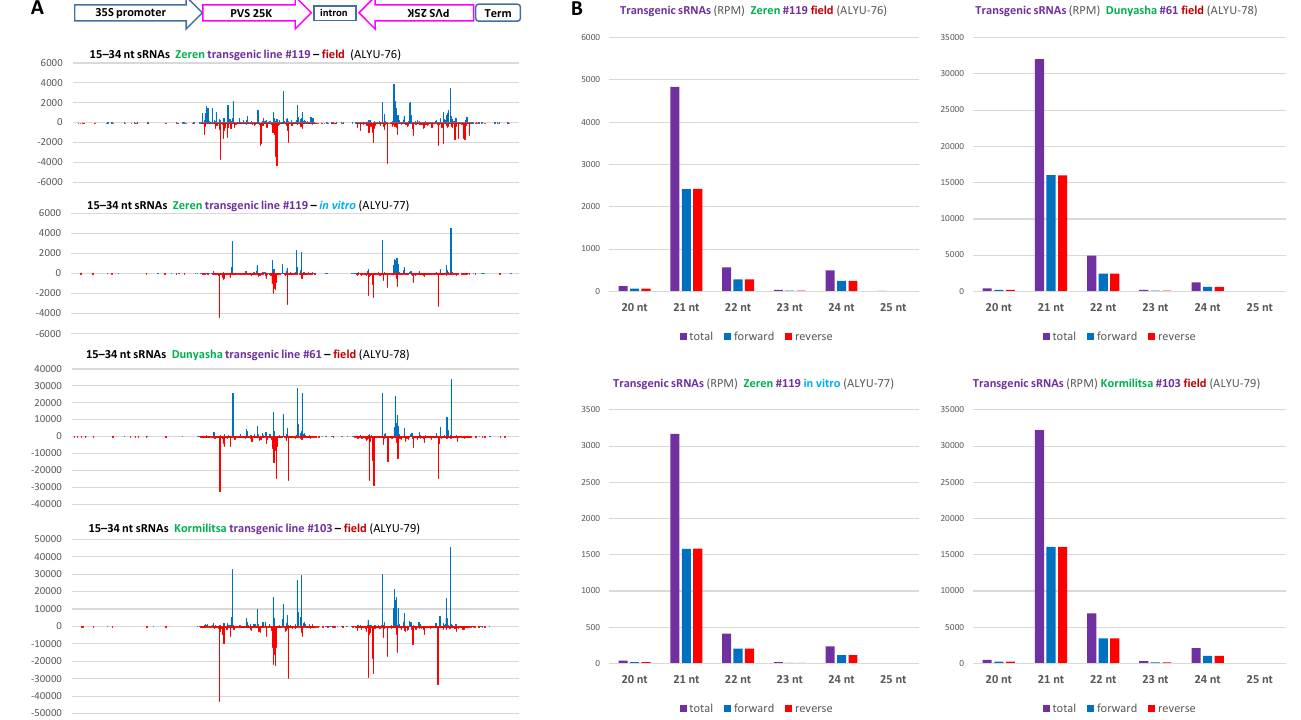
Figure 2. Single-nucleotide resolution maps and size profiles of transgene-derived sRNAs. ( A ) Single-nucleotide resolution maps of transgene-derived sRNAs. Redundant 15–34 nt sRNA reads obtained by Illumina sequencing of total RNA from leaf samples of the transgenic lines of cultivars Zeren (line #119: field plant ALYU-76 and in vitro plant ALYU-77), Dunyasha (line #61: field plant ALYU-78), and Kormilitsa (line #103: field plant ALYU-79) were mapped to the transgene expression cassette reference sequence (Dataset S1B) with zero mismatches; and single-nucleotide resolution sRNA maps were created by using MISIS-2 [28] (Dataset S3). The histograms plot the number of 15–34 nt sRNA reads at each nucleotide position of the 2743 bp transgene expression cassette. Bars above the axis represent sense (forward) reads starting at each respective position; those below represent antisense (reverse) reads ending at the respective position. The organization of the transgene expression cassette is shown schematically above the histograms: the CaMV 35S promoter, the PVS-25K-coding-sequence inverted repeats with the intervening intron, and the NOS terminator are delineated. ( B ) Size profiles and polarities of transgene-derived sRNAs. Redundant 20–25 nt sRNA reads mapped to the transgene expression cassette with zero mismatches were sorted by size (20, 21, 22, 23, 24, and 25 nt) and polarity (total, forward, and reverse) and counted in reads per million (RPM) of total 20–25 nt reads in each library (Dataset S2D). The resulting counts are plotted as bar graphs and color-coded. Our analysis of the 5 (cid:48) -terminal nucleotide identity of transgene-derived siRNAs revealed that 21 and 22 nt classes are enriched in 5 (cid:48) U (39 to 76%), followed by 5 (cid:48) A (14 to 41%) and 5 (cid:48) C (4 to 17%) (Figure 3A–D; Dataset S2C), suggesting their association with potato AGO1-, AGO2-, and AGO5-like proteins, respectively, as established in model plants (reviewed in Reference [18]). The 24 nt siRNAs were found to be enriched in 5 (cid:48) A (39 to 44%) and 5 (cid:48) U (27 to 39%) (Figure 3A–D; Dataset S2C), suggesting their association with potato AGO4-like and yet-to-be-identified AGO proteins,